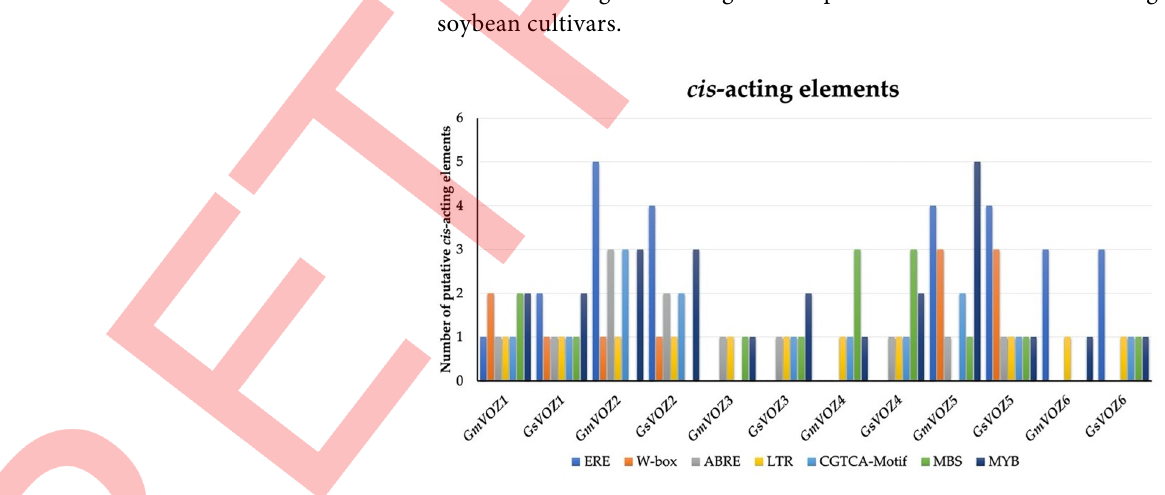
Fig 5. Putative cis -acting elements in a 2.0 kb 5’ flanking region upstream from the start codon of GmVOZs and GsVOZs